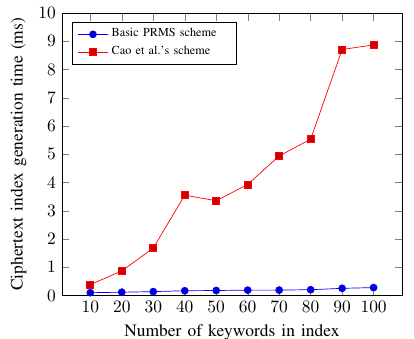
Figure 6. Time cost on ciphertext index generation.